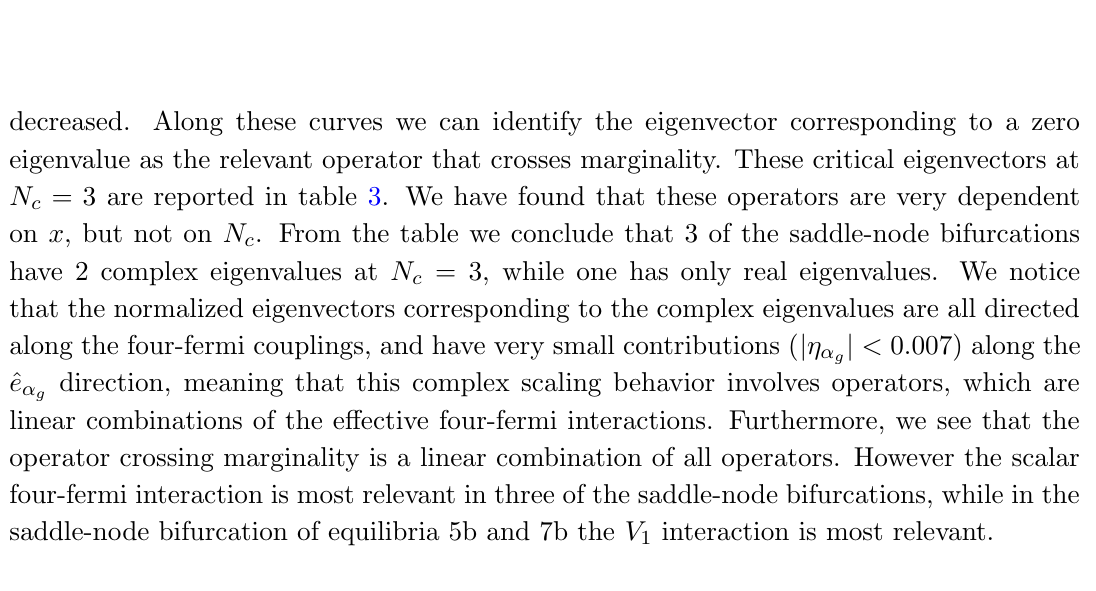
Table 3. Eigenvalues and critical eigenvectors crossing marginality of the saddle-node bifurcation with non-trivial (cid:11) g at N c =